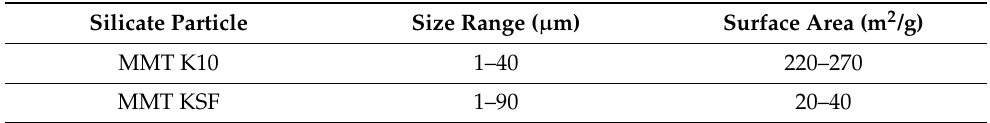
Table 1. Characteristics of silicate particles